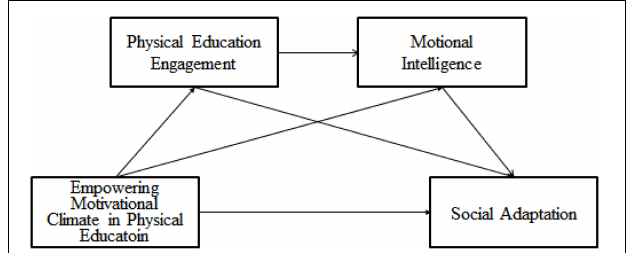
FIGURE 1 | Conceptual